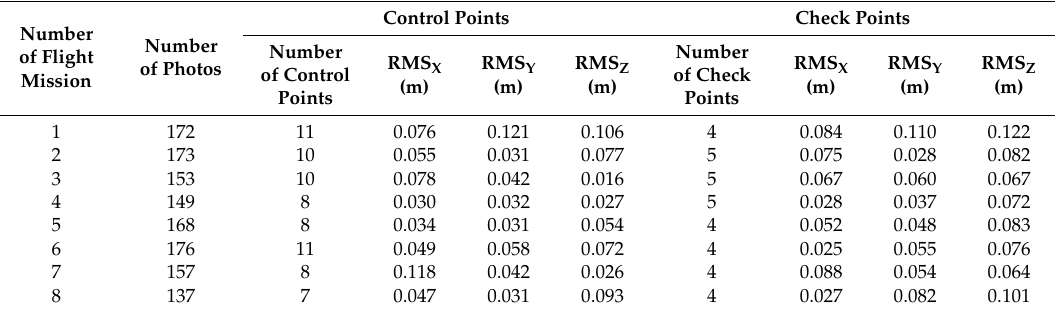
Table 2. Aerotriangulation results for 8 flight